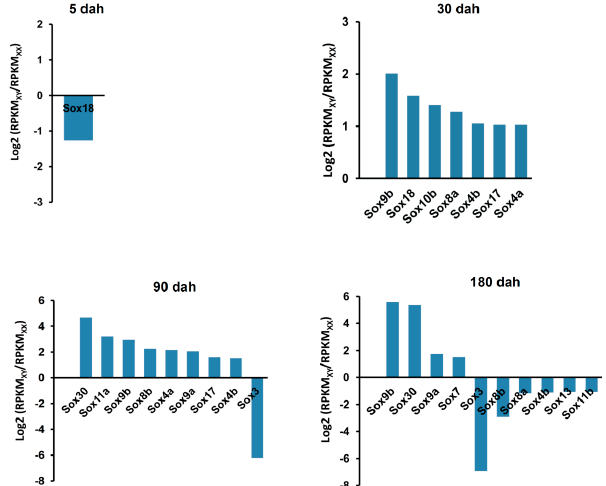
Figure 6. Differential expressions of the Sox genes between XX and XY gonads of the tilapia at different developmental stages. The ratio of RPKM value for the expression of each Sox gene in XX (ovary) and XY (testis) gonads in each developmental stage was calculated. If the log2 of the ratio is ≥ 1 or ≤− 1, this Sox gene was considered as sexual dimorphically expressed Sox genes in a developmental stage.